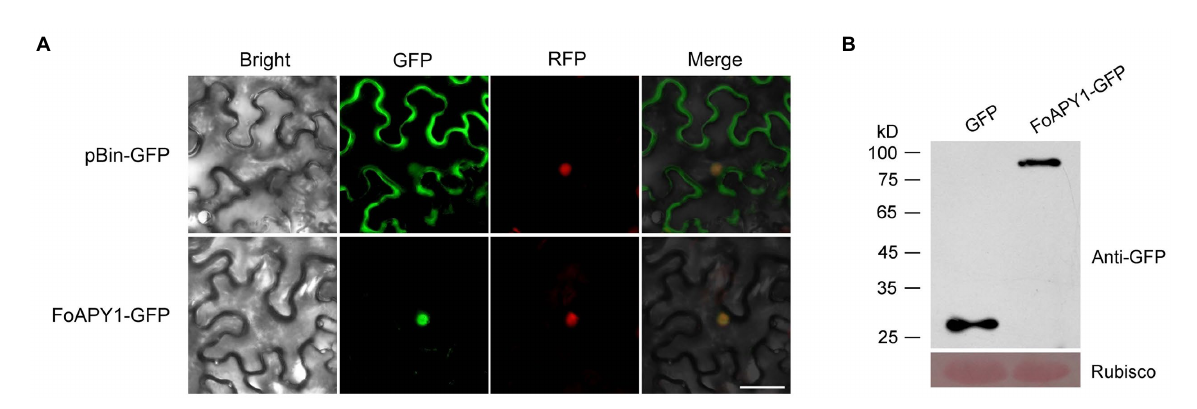
FIGURE 5 Subcellular localization of FoAPY1 in N. benthamiana . (A) Fluorescence microscopy analysis of N. benthamiana leaves subjected to Agrobacterium - mediated N. benthamiana transient expression of FoAPY1-GFP fusion protein (without signal peptide). The GFP tag alone was expressed in N. benthamiana leaves as a control. H2B-RFP (red fluorescent protein) was used for nucleus localization. All the images were taken at 48 h post- agroinfiltration. Bar = 20 μ m. (B) The proteins of N. benthamiana leaves expressed GFP or FoAPY1-GFP were analyzed by western blotting with Anti- GFP antibody. Equal loading amounts of protein were confirmed by staining Rubisco with Ponceau